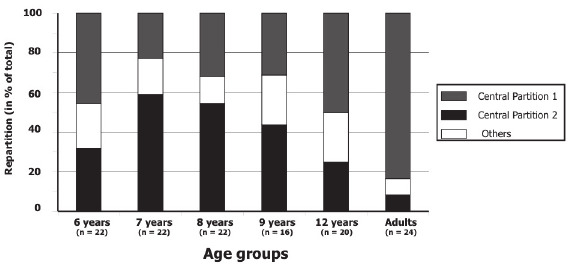
Fig 5. Proportions of Central Partitions 1 and 2 performed by the subjects according to their age. The other types of partitions have been grouped together (labeled “ Others Partitions ”